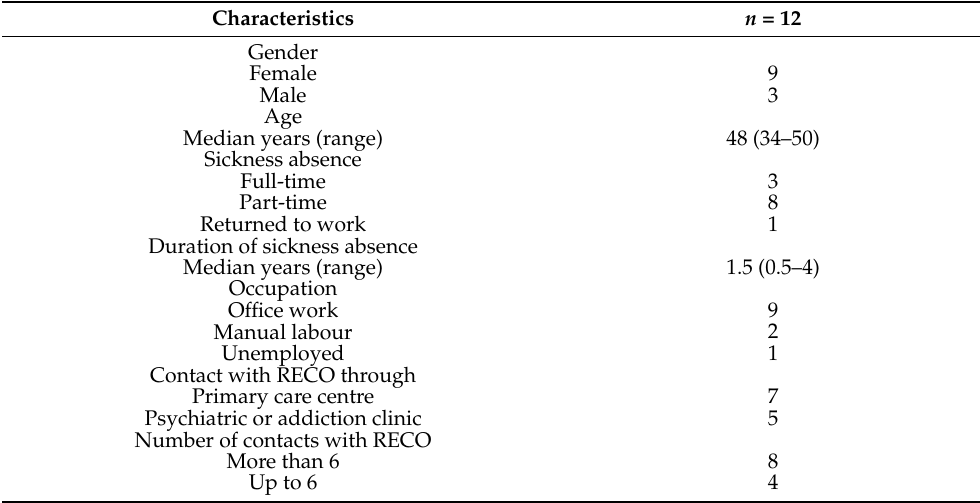
Table 1. Sociodemographic characteristics of the participants ( n =